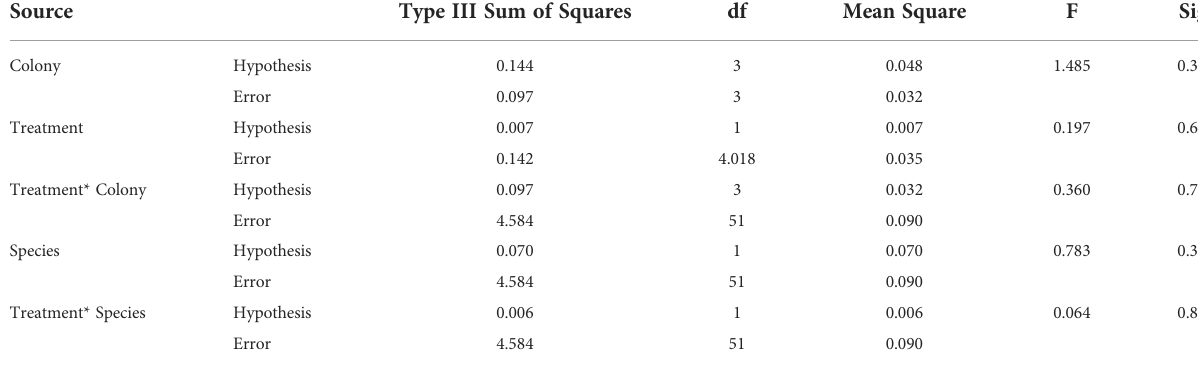
TABLE 2 ANOVA table for the split-plot design on growth rate of massive coral.